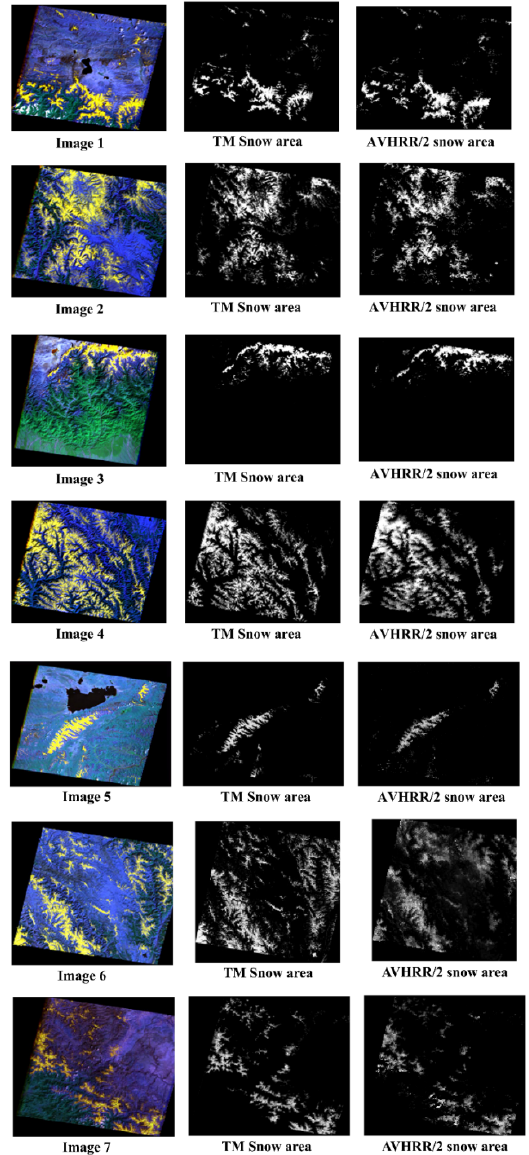
Figure 15. The comparison between snow cover distributions from AVHRR/2 data and TM data. For reducing the error of snow mapping from the geometric correction and varying spatial resolutions of the pixels in an AVHRR image, in this work the pixels of the validated data are resampled into four kinds of grids during the validation of the subpixel snow mapping, such as 1100 × 1100 m, 2200 × 2200 m, 4400 × 4400 m, and 8800 × 8800 m. The validation of the subpixel snow mapping is implemented according to the four classes of grid scales. At the edge of the swath, the spatial resolution is much coarser than in nadir, so the larger of the grids are more reliable for validating the pixels at the edge of the swath. With increasing grid scales, the error from the coarser resolutions at the edge and geometric correction should become smaller, and the accuracies of the validation higher (shown in Table 2).